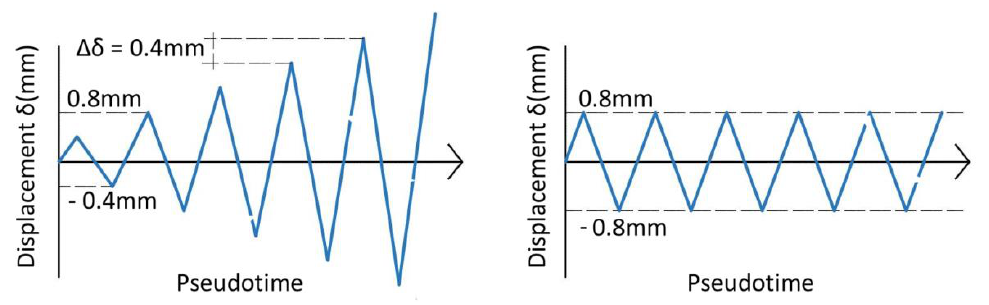
Figure 6. Load patterns applied to specimens DC1 to DC5 ( left ) and DC6 to DC10 ( right ). Table 1. Number of cycles and maximum displacement reached by specimens DC1 to DC5.